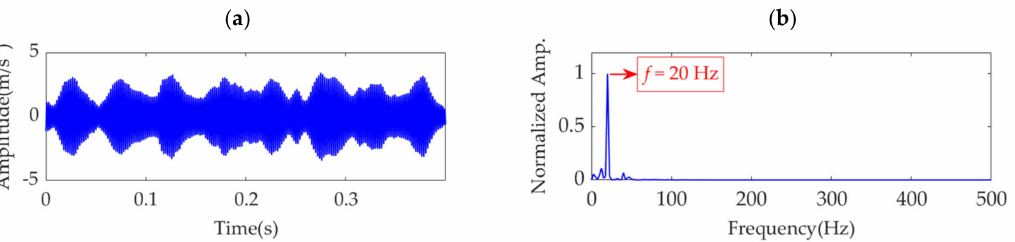
Figure 9. Target mode obtained by VMD: ( a ) time–domain waveform and ( b )